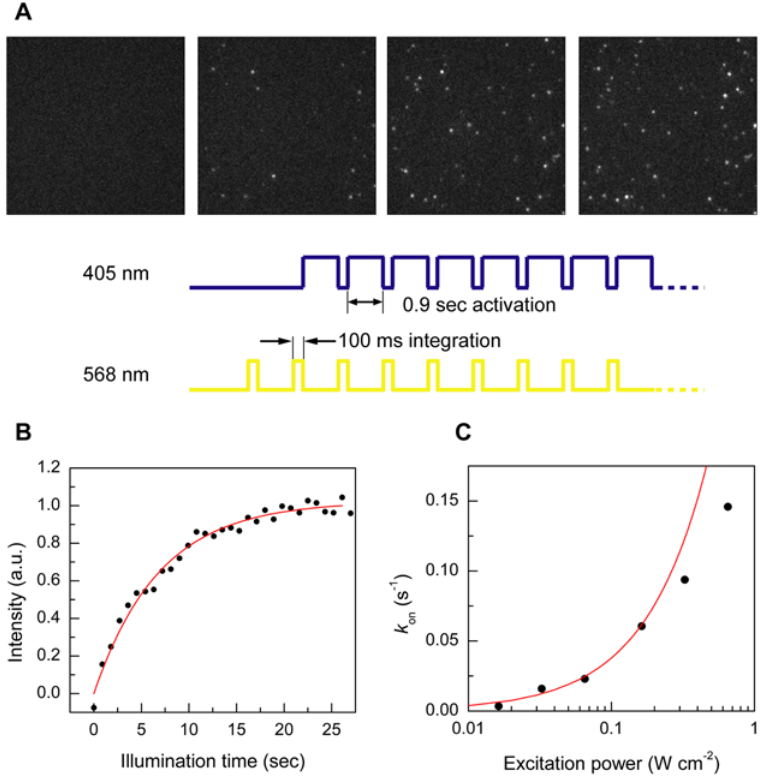
Figure 5. Photoswitching of mKikGR at the single-molecule level. (A) Fluorescence images of individual red mKikGR molecules embedded in polyacrylamide gel (100 pM, pH 7.0). The images were recorded with 568 nm excitation (130 W cm 2 2 , 100 ms integration, 1 Hz). The sample was illuminated with 405 nm light (33 mW cm 2 2 ) between 568 nm pulses. The images were recorded after 0, 1.8, 8.1, and 22 seconds total illumination time with 405 nm light. (B) Time course of integrated intensities of the images. The solid line shows fitting with a first order kinetic model. (C) Excitation power dependence of the photoswitching rates determined from the single-molecule measurements. The solid line shows theoretical switching rate calculated from bulk experiments.